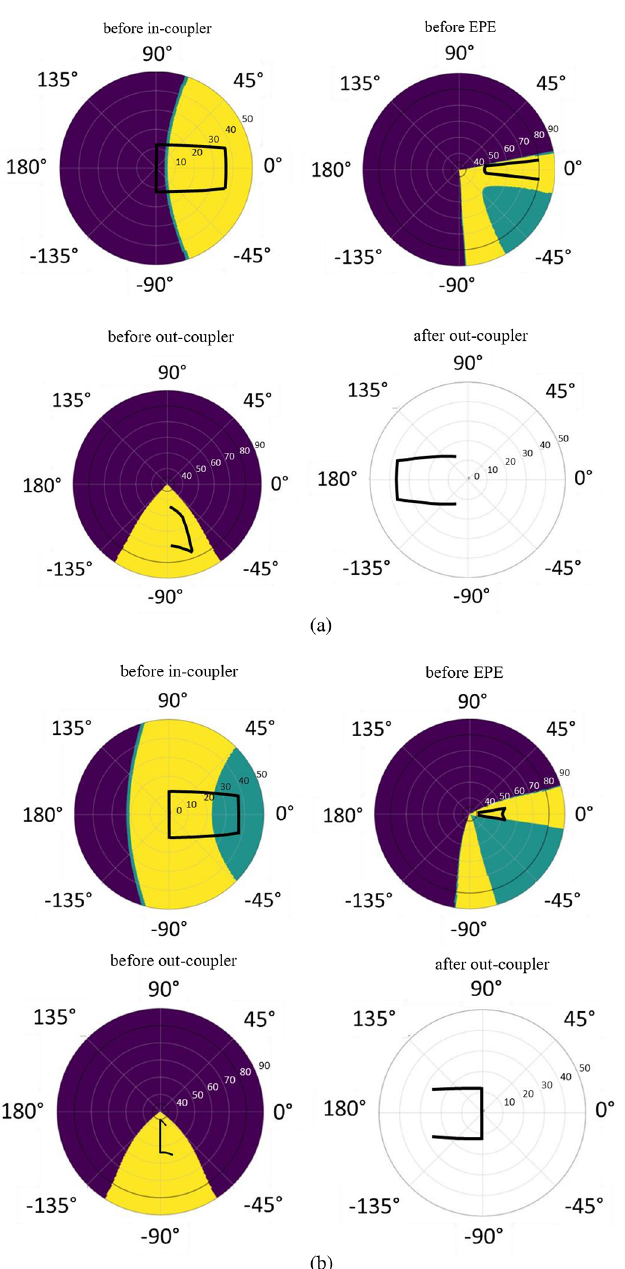
Fig. 14. Possible FoV for the system of metagratings. Para- meters of the diffraction gratings are presented in Table 1. Simulations corresponds to the systems (a) DG1+DG3+DG7 and (b) DG2+DG4+DG8 at green color wavelength. In the pictures (a)-(b) top left : Angular bandpass before in-coupler; top right : Angular bandpass before EPE; bottom left : Angular bandpass before out-coupler; bottom right : Angular bandpass after out- coupler; yellow band : Proper angular bandpass after diffraction; green band : Nonproper angular bandpass after diffraction; purple band : Bandpass impossible for